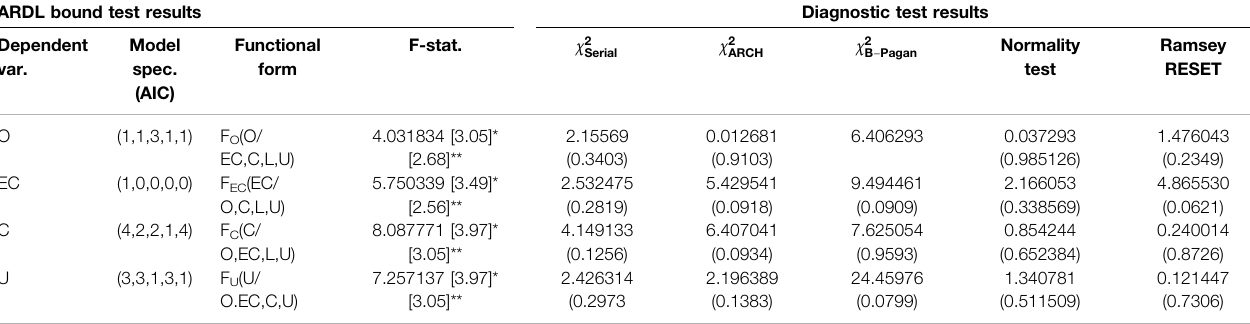
TABLE 2 | ARDL bound co-integration F-tests and diagnostic tests.